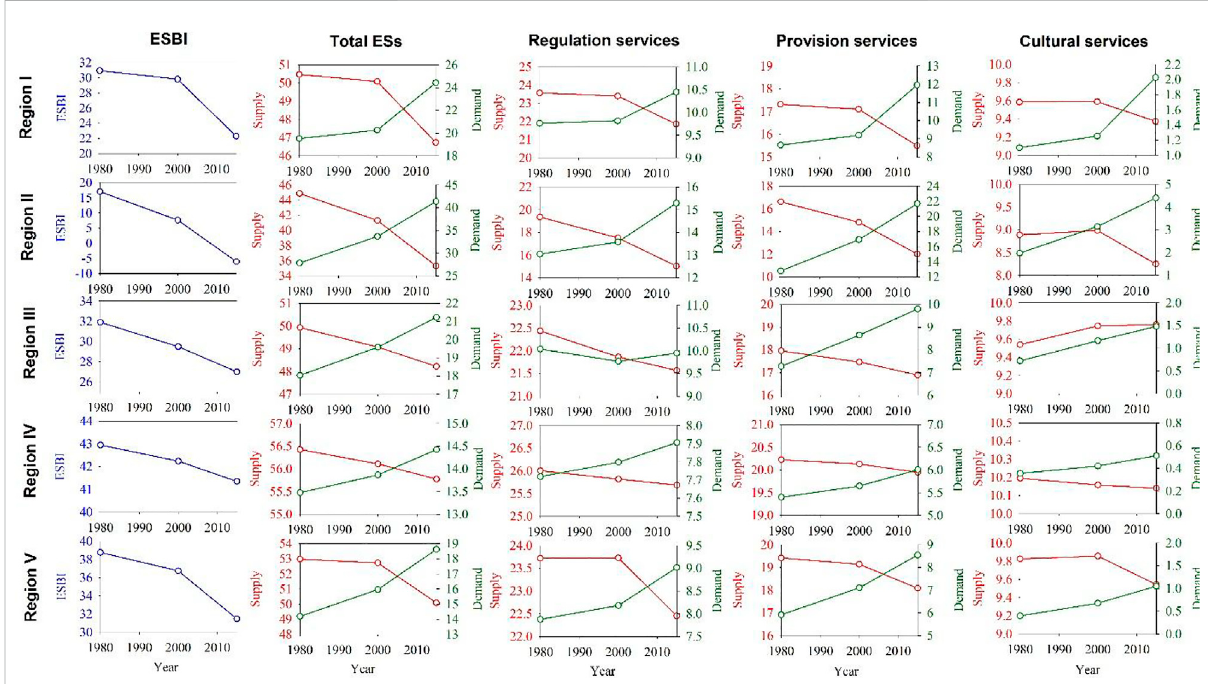
FIGURE 5 Temporal changes in the ESBI and supply and demand of total ESs and different categories of ESs in fi ve hotspots of rapid urbanization. Blue, green,andredlinesrepresentthebudgetindex,supply,anddemandofESs,respectively.Forgeographiclocationsofrapidlyurbanizingregions,refer to Figure